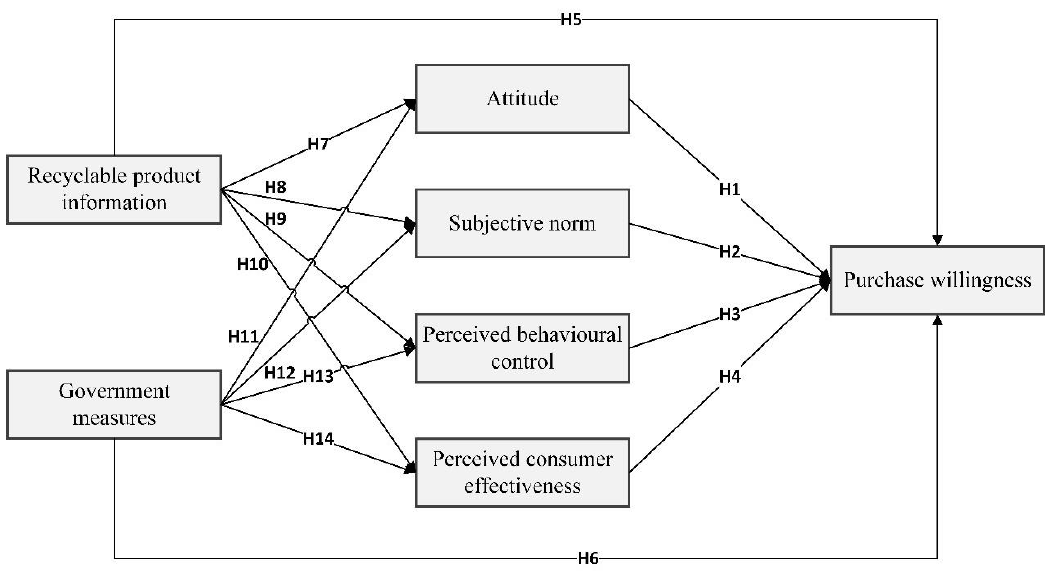
Figure 1. The preliminary hypothetical model.